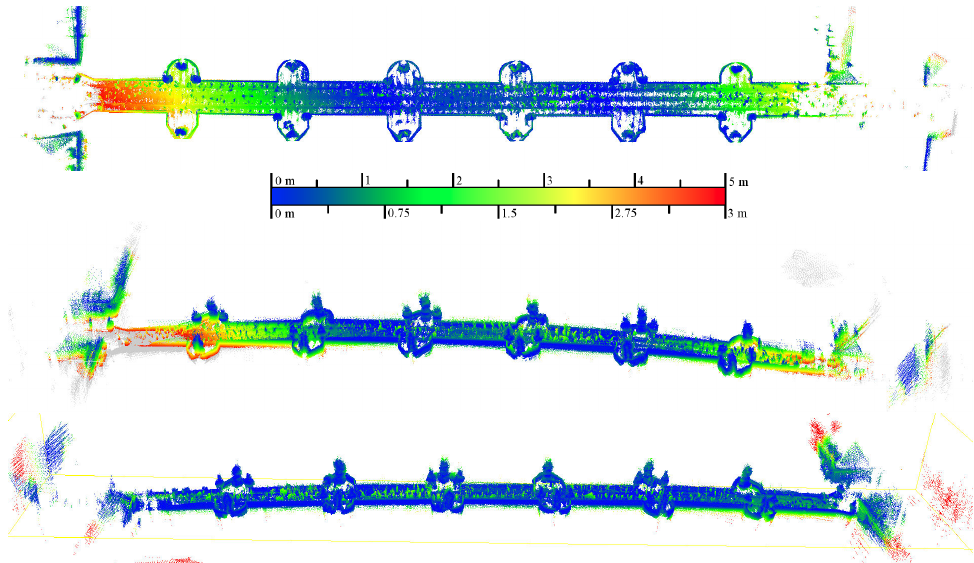
Figure 11. Final point clouds of ”The Bridge” as topview (top) and sideview. The sideview is shown without (above) and with (below) the initialization using the Kalman filter. The colors show the point-to-point distance respective to the presented color scale. The topview has a gradient from 0 m (blue) to 5 m (red), where as the sideview only goes to 3 m to make details in the middle of the bridge more distinguishable. Grey points have a point-to-point distance outside of that range.